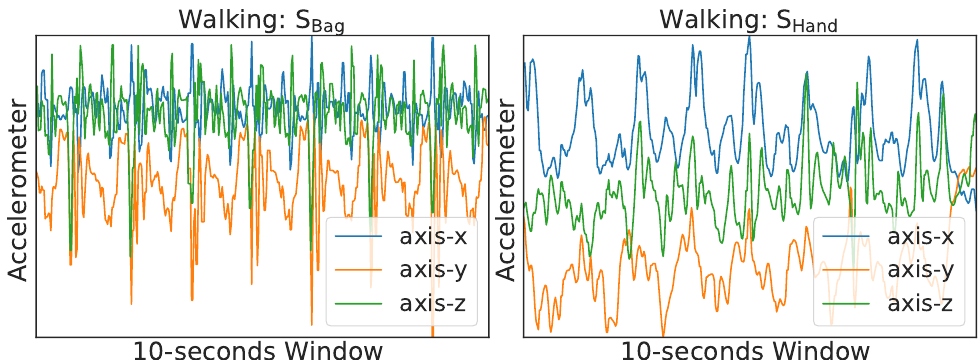
Figure 1. The effect of different phone placements on sensor data can be seen in triaxial accelerometer tracings for the same walking activity but with different phone prioceptions.